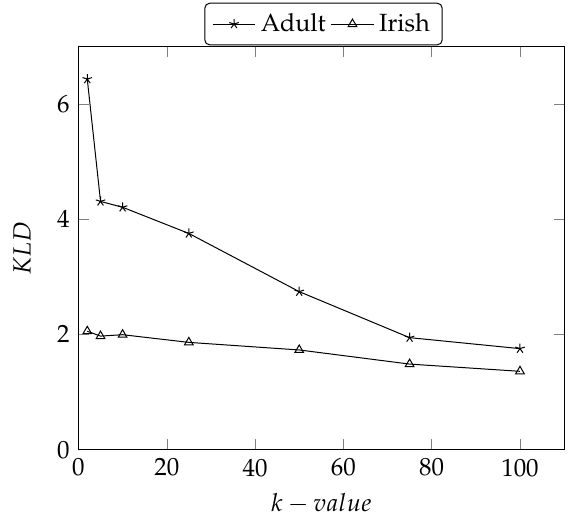
Figure 12. KLD Performance of privacy.